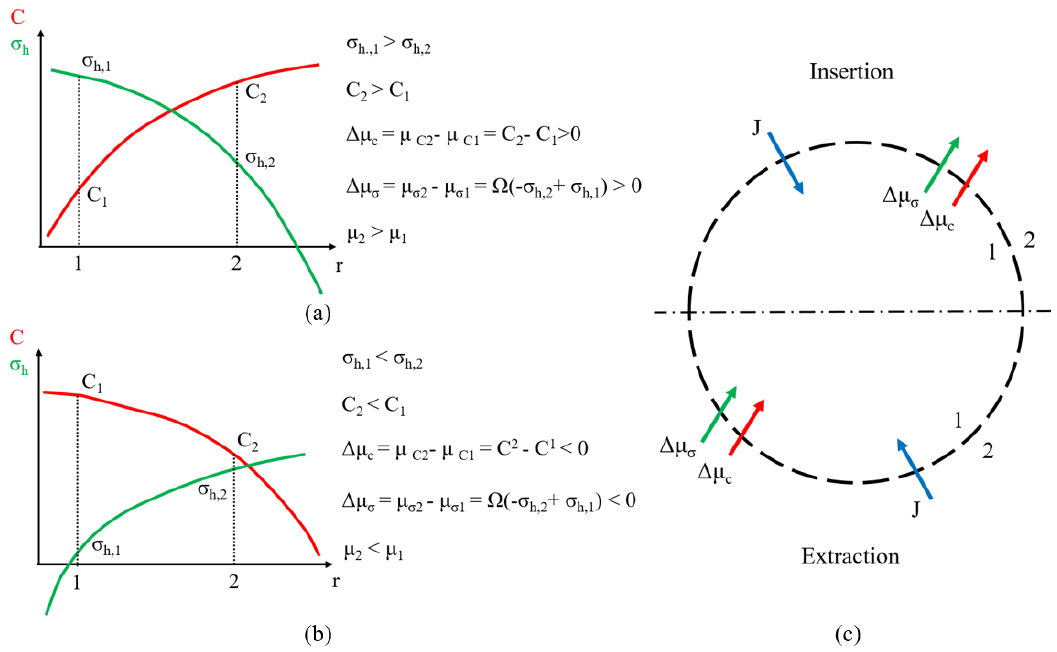
Figure 9. Hydrostatic stress influence on lithium diffusion for insertion and extraction operation. The qualitative trend of the lithium concentration (red) and the hydrostatic stress (green) for insertion ( a ) and extraction ( b ) are reported in the graphics. The chemical potential is split in concentration contribution and hydrostatic stress contribution whose increments are valued for a general radial position r . The stress and concentration contributions for a general radial coordinate are graphically reported with green and red arrows which goes from the lower to the higher value ( c ). The lithium flux due to the chemical potential difference is reported with the blue arrows ( c